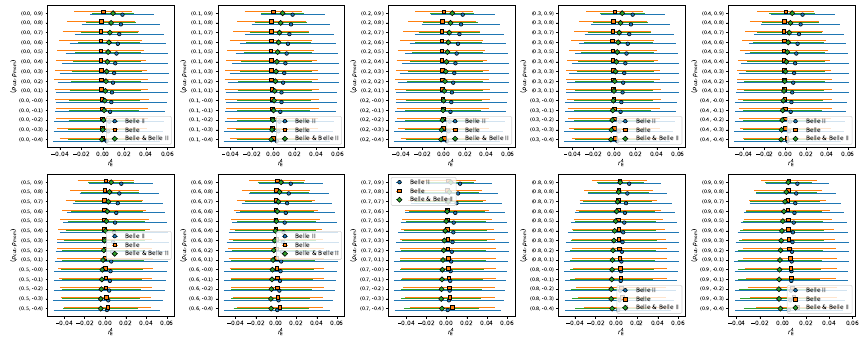
for different combinations of correlation parameter Figure 13 . Fit results for r 4 E